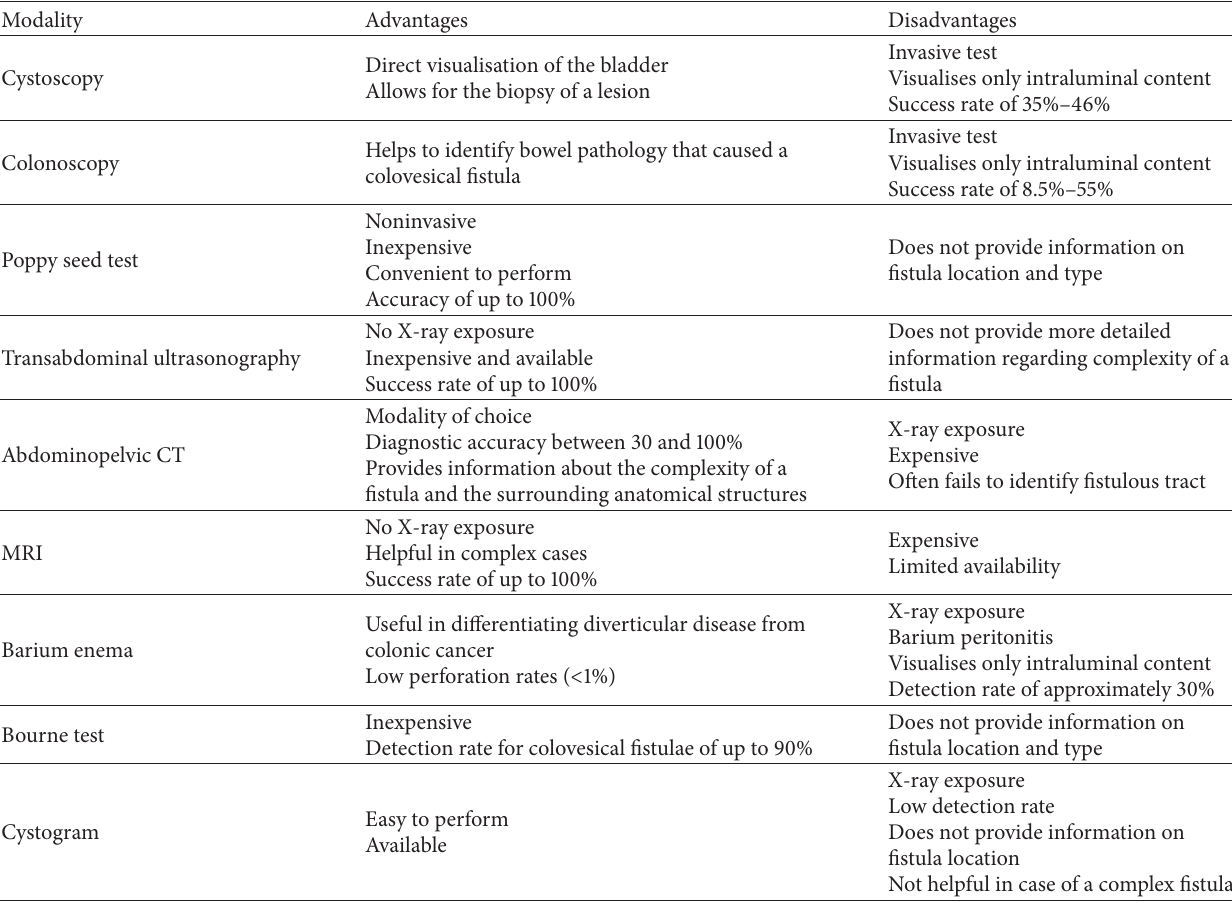
Table 1: Advantages and disadvantages of diagnostic tests and procedures used for the detection of enterovesical